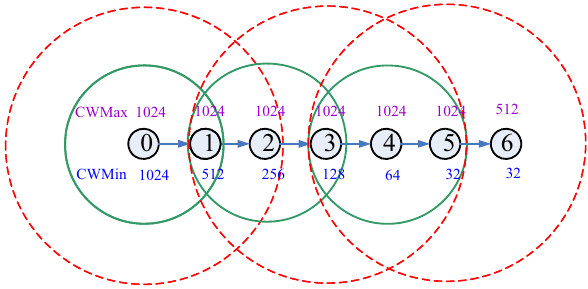
Fig. 3 A 7-nodes chain topology for multi-hop ad hoc